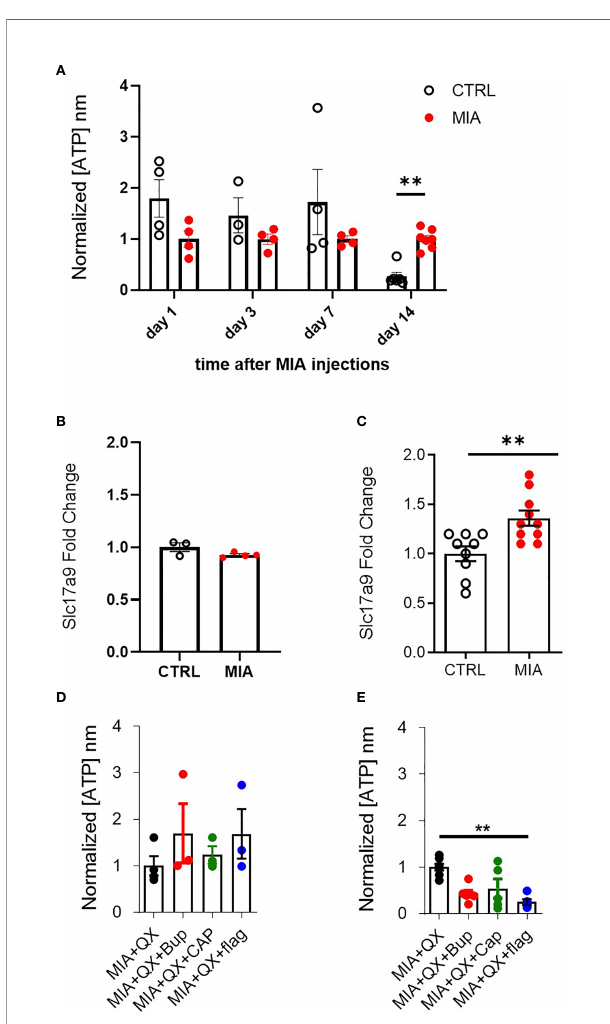
FIGURE 4 | VNUT and ATP expression following MIA-induced joint injury. (A) Timecourse of ATP content after MIA injections in male rat cerebrospinal fl uid (CSF) (N=3 to 8 animals per group). (B) Expression of Slc17a9 mRNA transcripts in CTRL and MIA injected animals at day 7 (N=3 CTRL, 4 MIA) and (C) day 14 (N=9 CTRL, 10 MIA). (D) ATP content in CSF 7 days after MIA injections in QX-treated animals. Kruskal-Wallis analysis detected no signi fi cant changes (N=3 to 4 animals per group). (E) ATP content in CSF 14 days after MIA injections in QX-treated animals (N=5 to 7 animals per group).